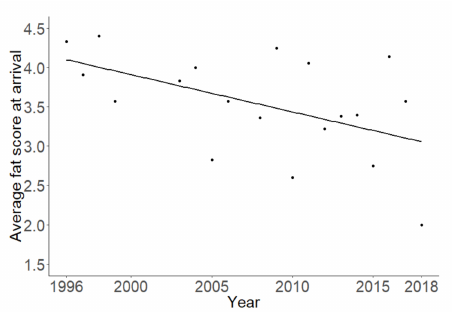
Figure 4. Average fat score of the Pied Flycatchers at arrival over the years.